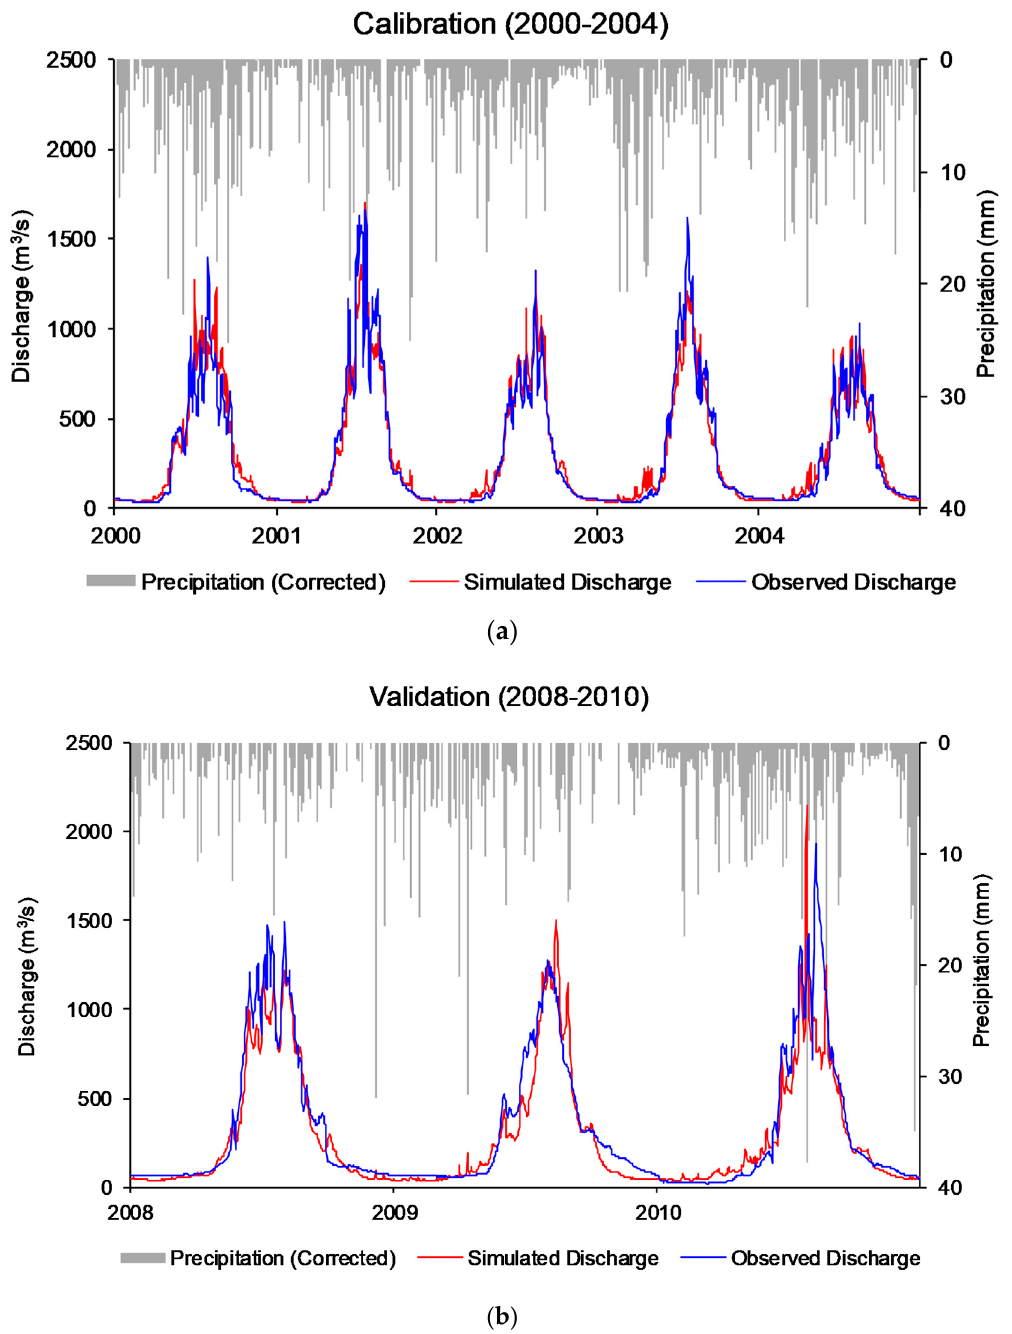
Figure 5. Hydrograph during ( a ) the calibration period, and ( b ) the validation period.